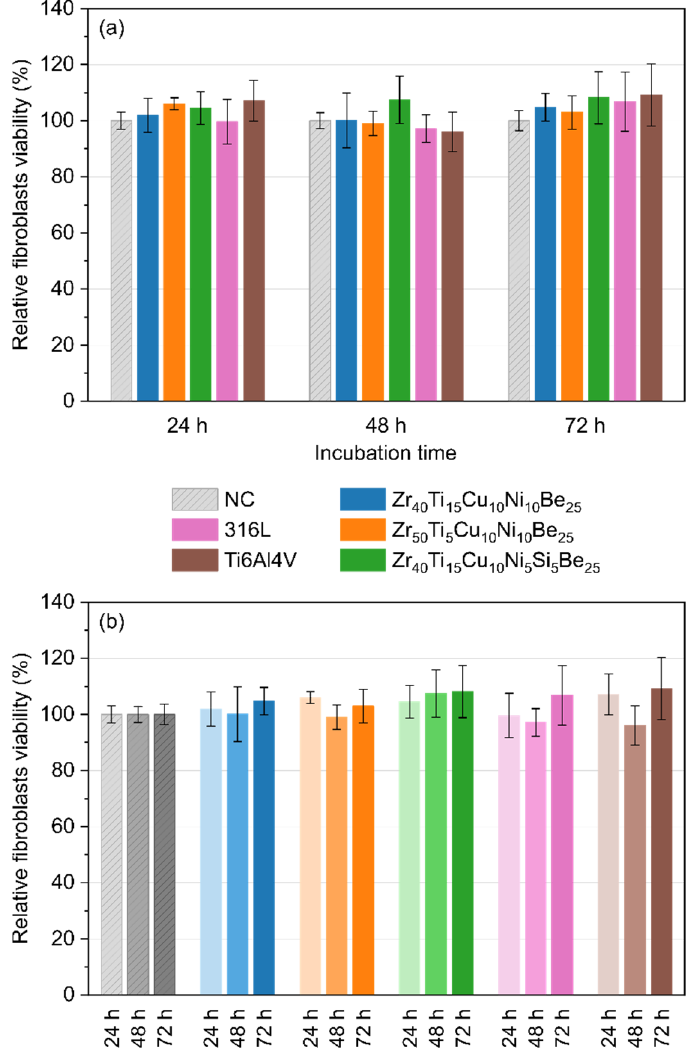
Figure 8. Relative viability of fibroblasts (IMR90 cell line) in extraction media from Zr 40 Ti 15 Cu 10 Ni 10 Be 25 , Zr 50 Ti 5 Cu 10 Ni 10 Be 25 , Zr 40 Ti 15 Cu 10 Ni 5 Si 5 Be 25 alloys, 316L stainless steel, and Ti6Al4V alloy evaluated by MTT assay carried out at 24 h, 48 h, and 72 h time intervals – compatison between samples at the same incubation time ( a ), and influence of incubation time for each material ( b ). Cell viability of untreated cells (NC) was considered to be 100%.